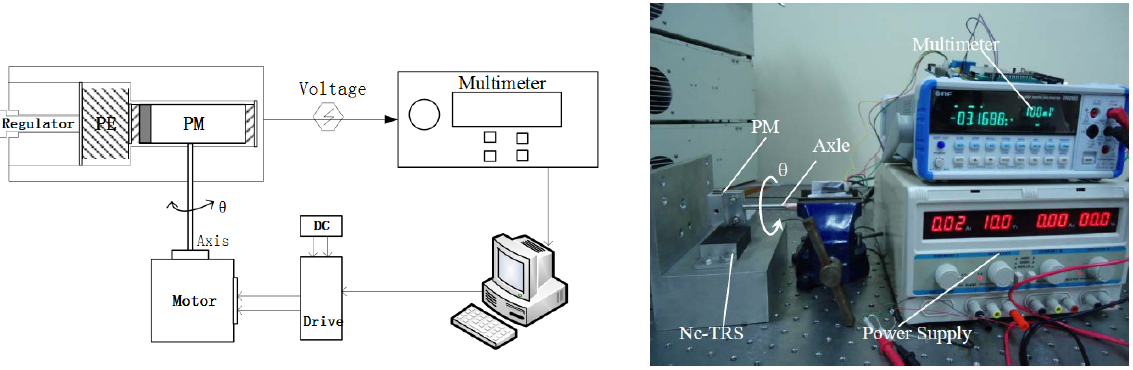
Figure 5. Schematic diagram and photograph of the experimental setup for angle